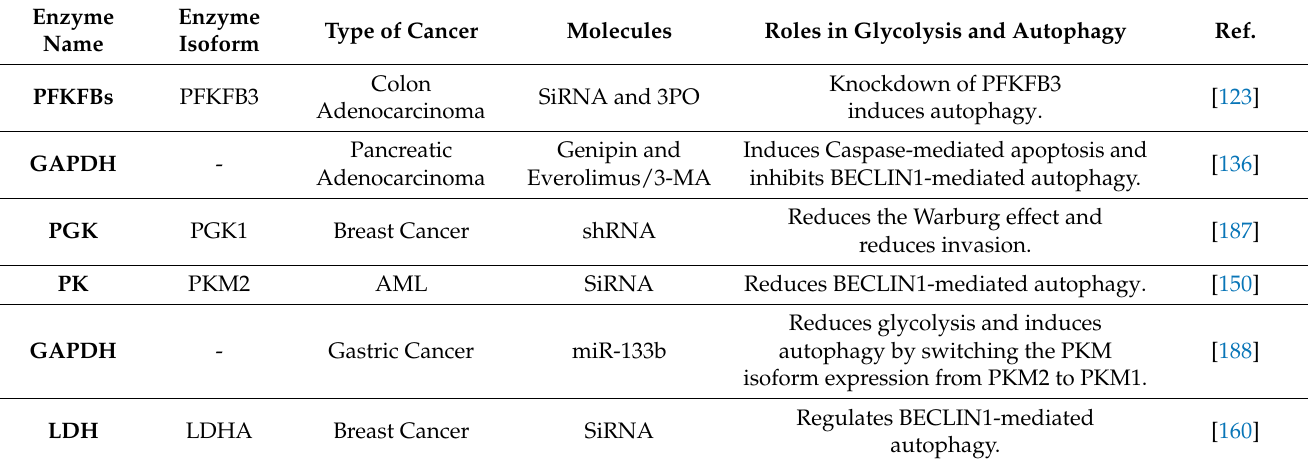
Table 1. Glycolysis-related enzymes involved in the regulation of